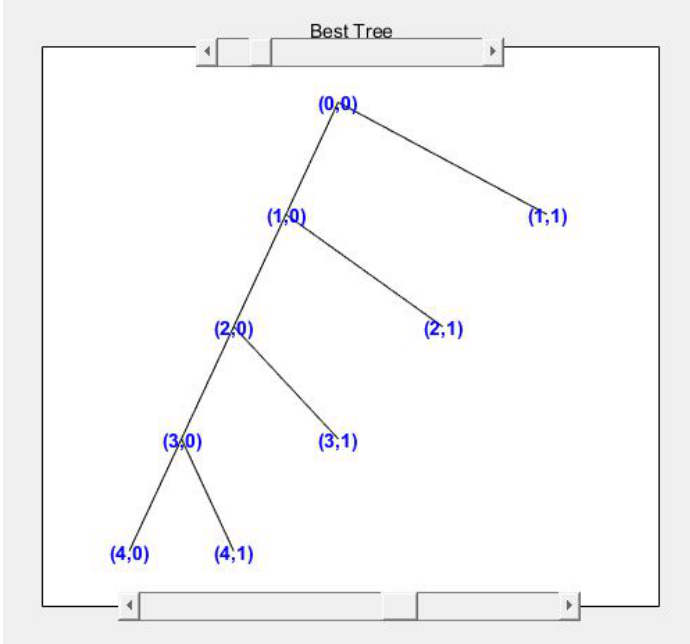
Figure 6. ECG Wavelet